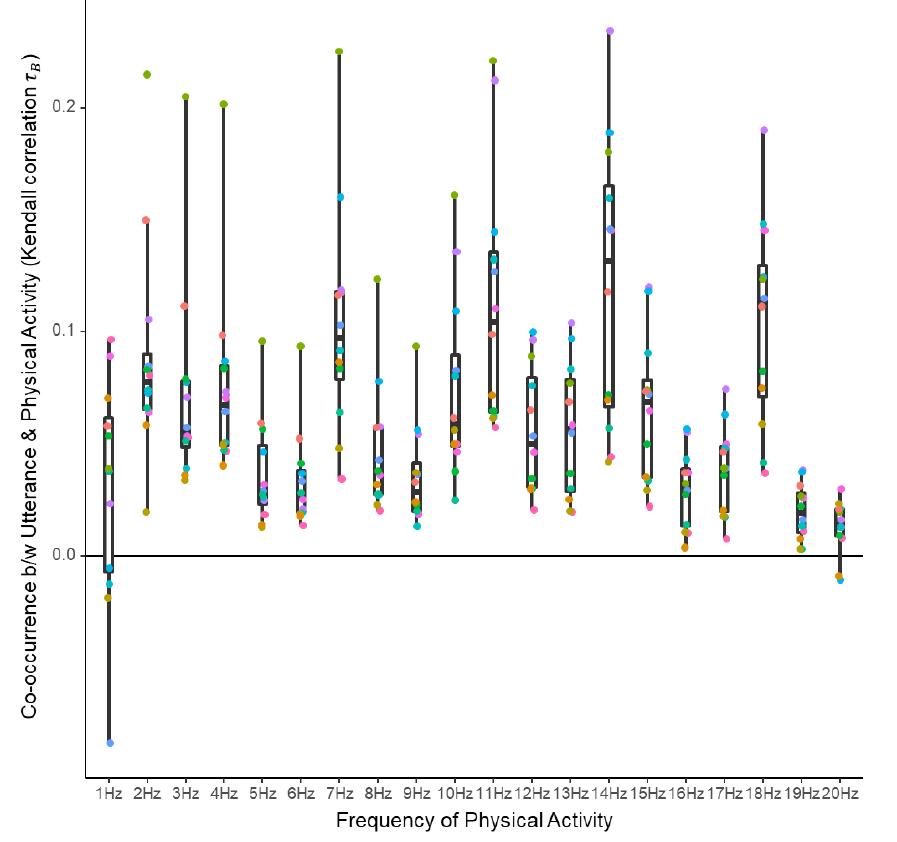
Figure 3. Kendall rank correlation coefficients indicating concurrent occurrence of utterances and physical motions at different frequencies. Colored points indicate different participants.